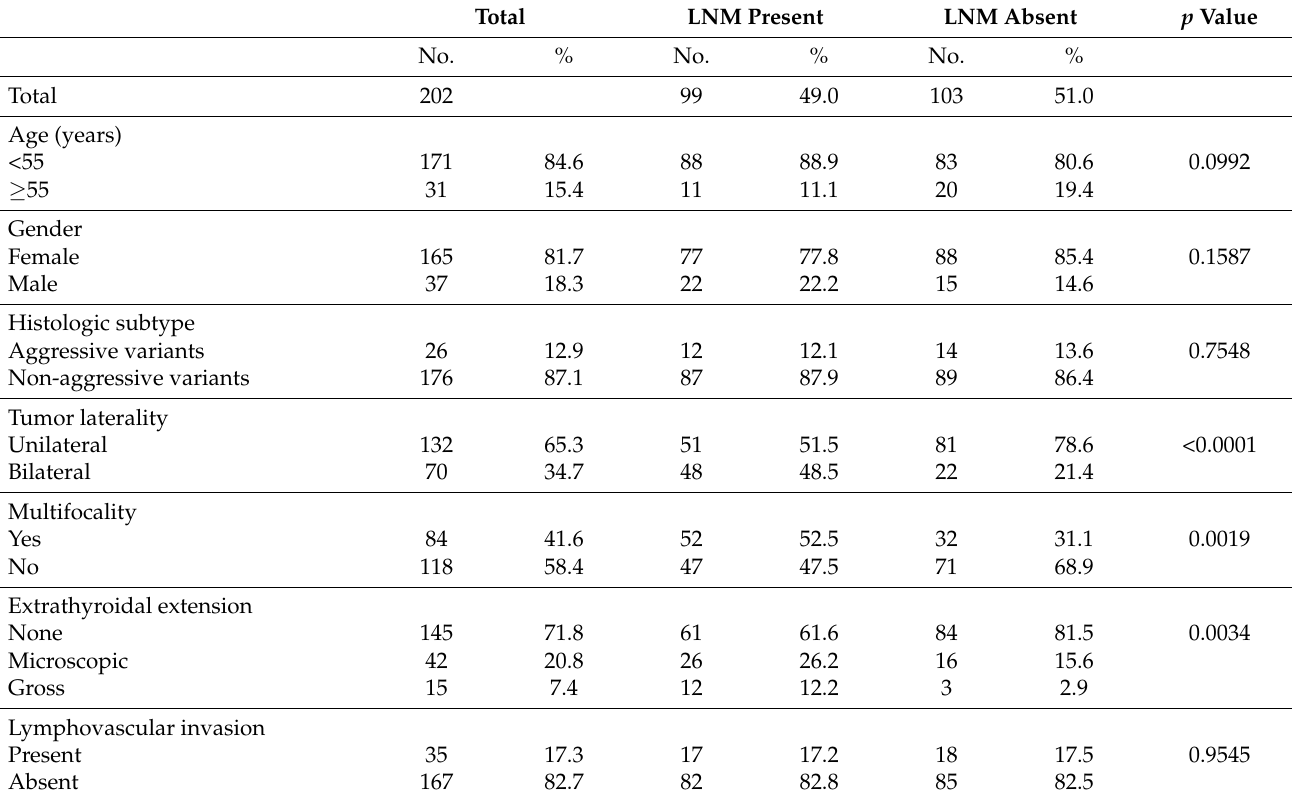
Table 2. Clinico-pathological associations of lymph node metastasis in papillary thyroid microcarcinoma.